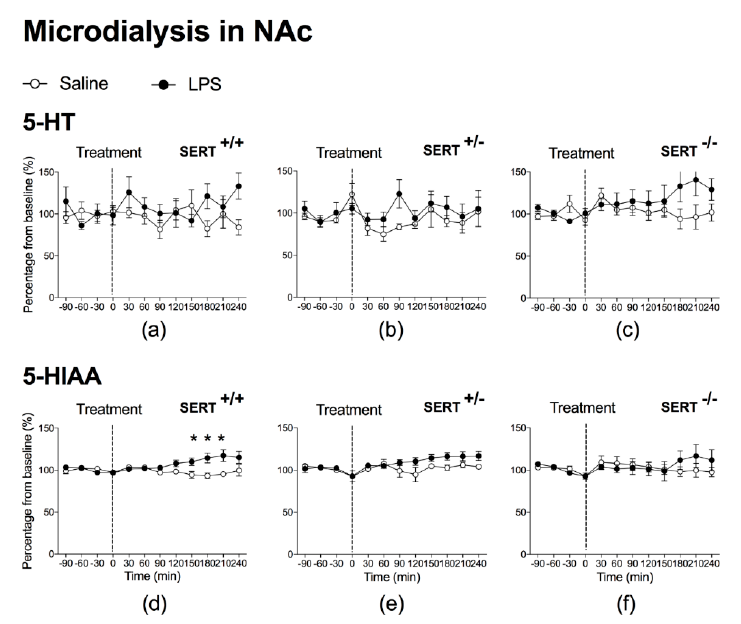
Figure 1. Microdialysis in the Nucleus Accumbens (NAc). At t = 0 min, rats received Saline or lipopolysaccharides (LPS). Graph represents percentage from baseline (%) of 5-HT and 5-HIAA from each time point (min). Animals ( n ) per group were as follows: n = 6 for Saline-SERT +/+ rats ( a , d ) and n = 7 for LPS-SERT +/+ rats ( a , d ); n = 3 for Saline-SERT +/ − rats ( b , e ) and n = 7 for LPS-SERT +/ − rats ( b , e ); n = 5 for Saline-SERT − / − rats ( c , f ) and n = 5 for LPS-SERT − / − rats ( c , f ). Significance: * p < 0.05.